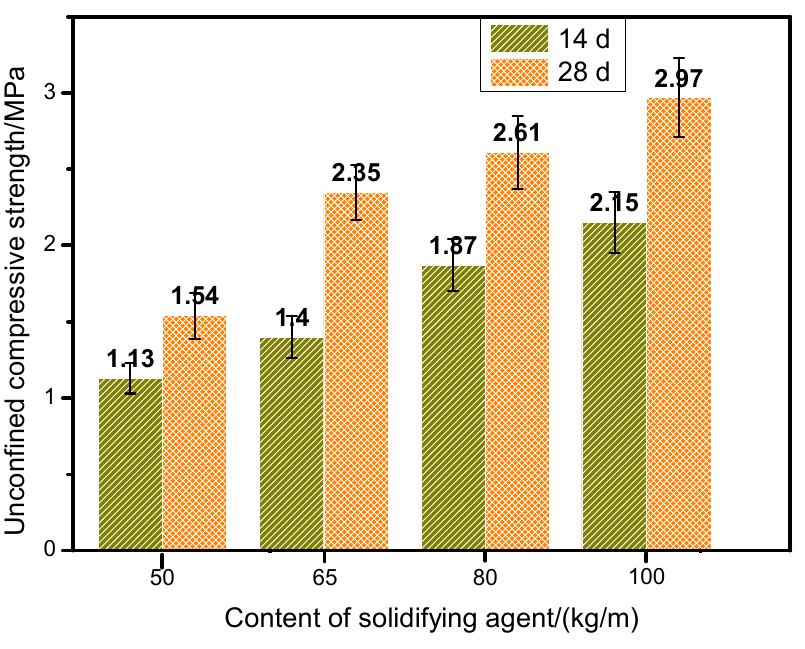
Figure 9. Effect of the content of the solidifying agent on the unconfined compressive strength of the mixing pile.